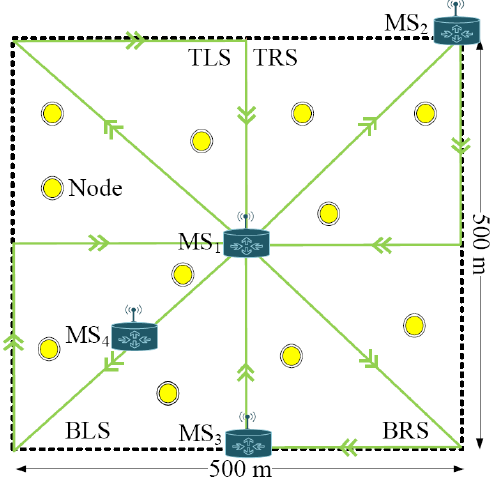
Figure 10. Proposed Network Model [44].